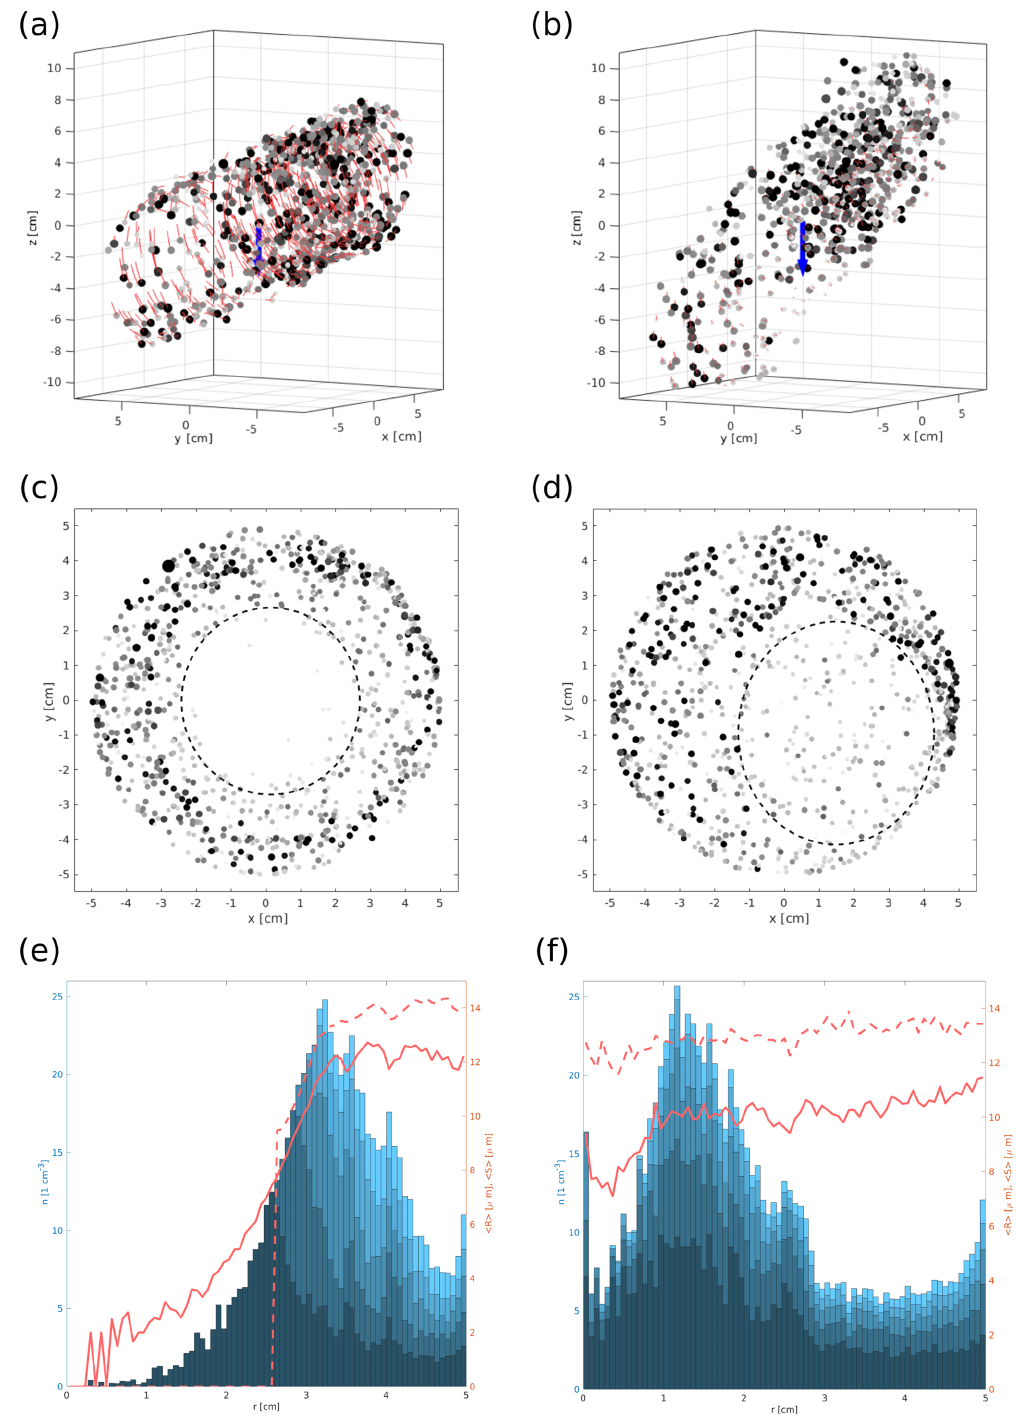
Figure 6. Positions of droplets in simulations (1) (a, c) and (2) (b, d) as described in Table 5 in perspective view (a, b) and in 4cm thick central slice projected on a plane perpendicular to the vortex axis (c, d) . The blue arrow shows the direction of gravity. In panels (a) – (d) , droplet size and color are scaled, respectively, to the rules described in Sect. 5. The red tracks behind the particles in panels (a) and (b) reflect the last (cid:49)t = 0 . 0055s of the droplet trajectory (for clarity, every 10th droplet is drawn). The dashed circles in panels (c) and (d) reflect the approximate shape and size of the visible void in the droplet field. Panels (e) and (f) present the number concentration of droplets n with different blue shading colors representing the contribution from different size groups – left axis, droplet mean real radius (solid red line) and mean visible radius (dashed red line) – right axis, all with respect to the distance from the vortex axis r .